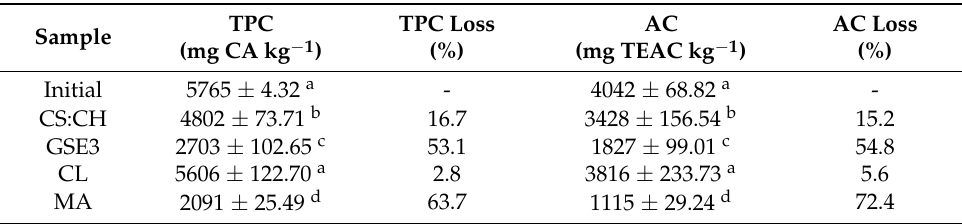
Table 2. Total phenolic compounds (TPC) and antioxidant capacity (AC) of blueberries var. Emerald stored for 30 days at 1 ◦ C and then submitted 7 days at room